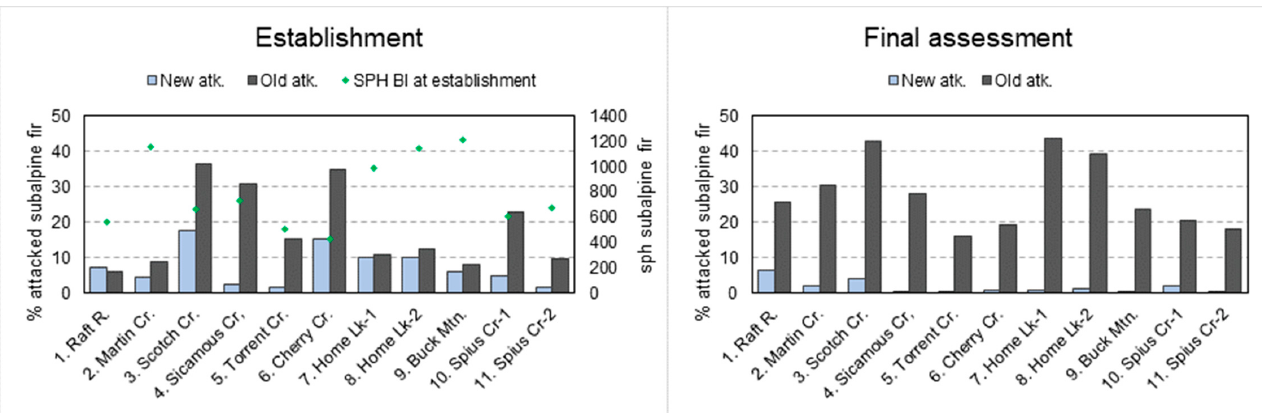
Figure 6. Comparison of the percentage of D. confusus -attacked subalpine fir containing a brood (new attack) and those no longer containing a brood (old attack) at stand establishment and final assessment. Density at establishment is also shown. The new attack includes tree codes 1–3 and old attack includes tree codes 4–5.